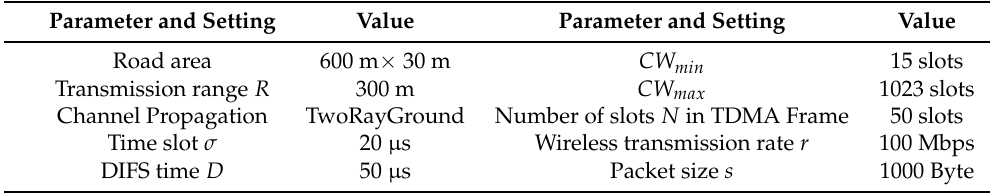
Table 1. Road Traffic Parameters and medium access control (MAC) protocol Setting. TDMA: Time Division Multiple Access. DIFS: Distributed Inter-frame Spacing.